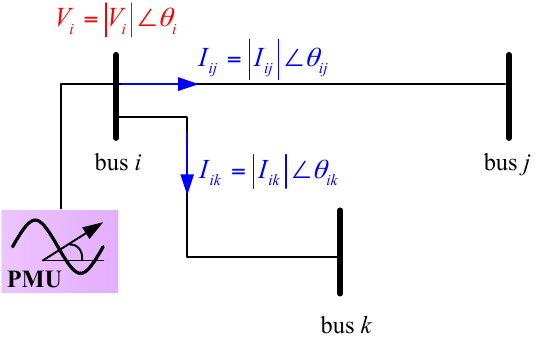
Figure 1. Three-bus system with phasor measurement unit (PMU) installed at bus i .